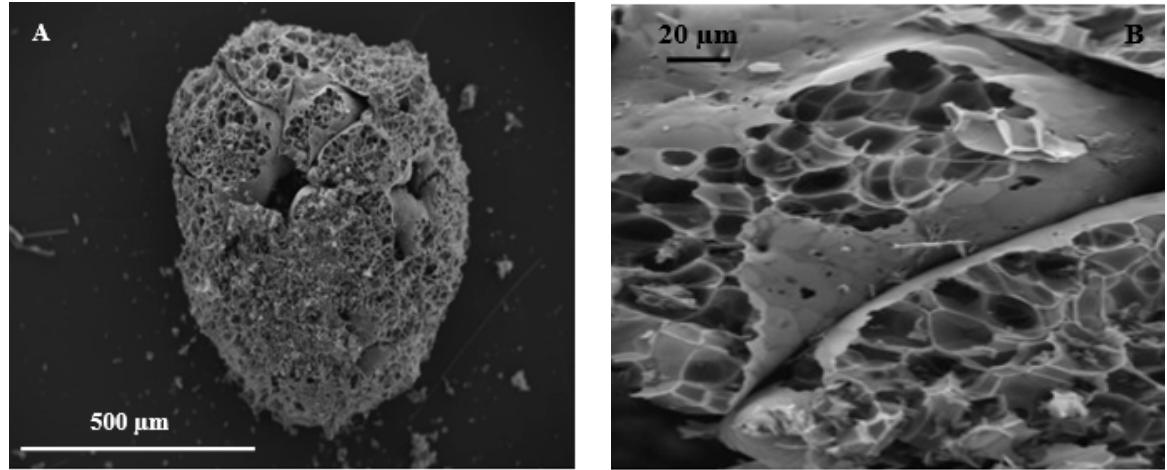
Figure 6. SEM image of a ( A ) perlite bead and ( B ) bead magnification (inner porosity).